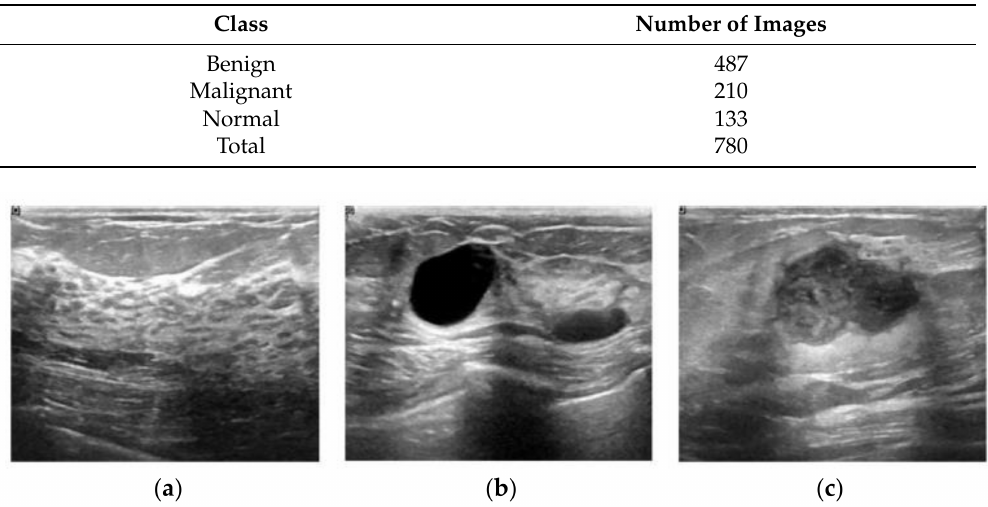
Table 1. Three classes of breast US images and the number of images in each class.